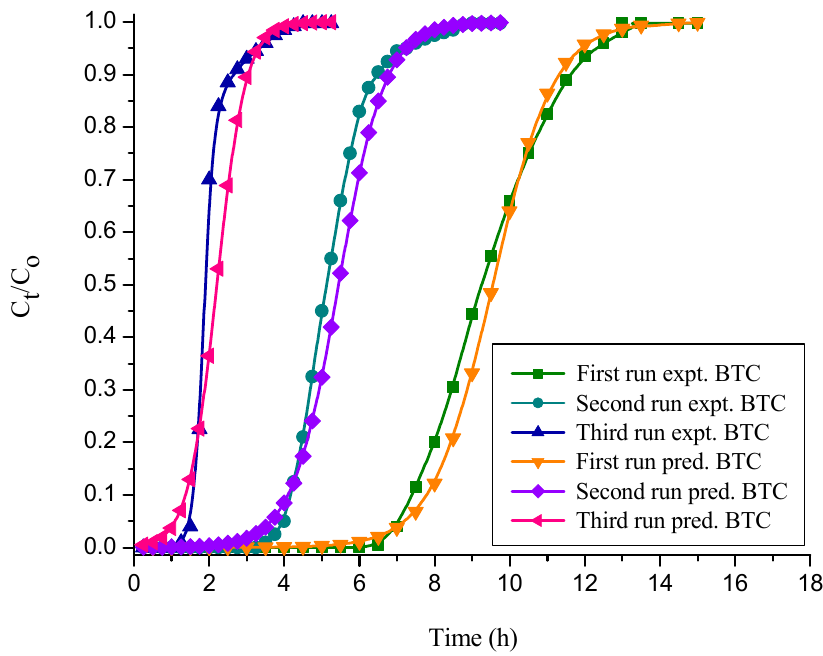
Figure 9. BTCs for experimental vs. simulated Yoon–Nelson model for the decolorization of CR dye by sodium silicate gel-immobilized NNLP adsorbent in various runs. (Initial pH: 6; flow rate: 1 mL min − 1 ; inlet dye concentration: 15 mg L − 1 ; temperature: 301 K)